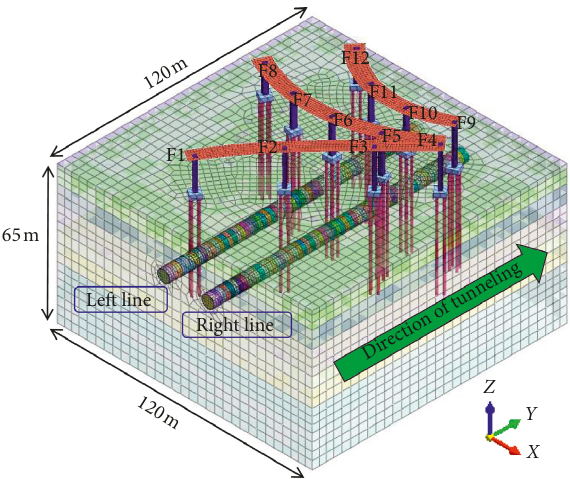
Figure 6: Three-dimensional finite element